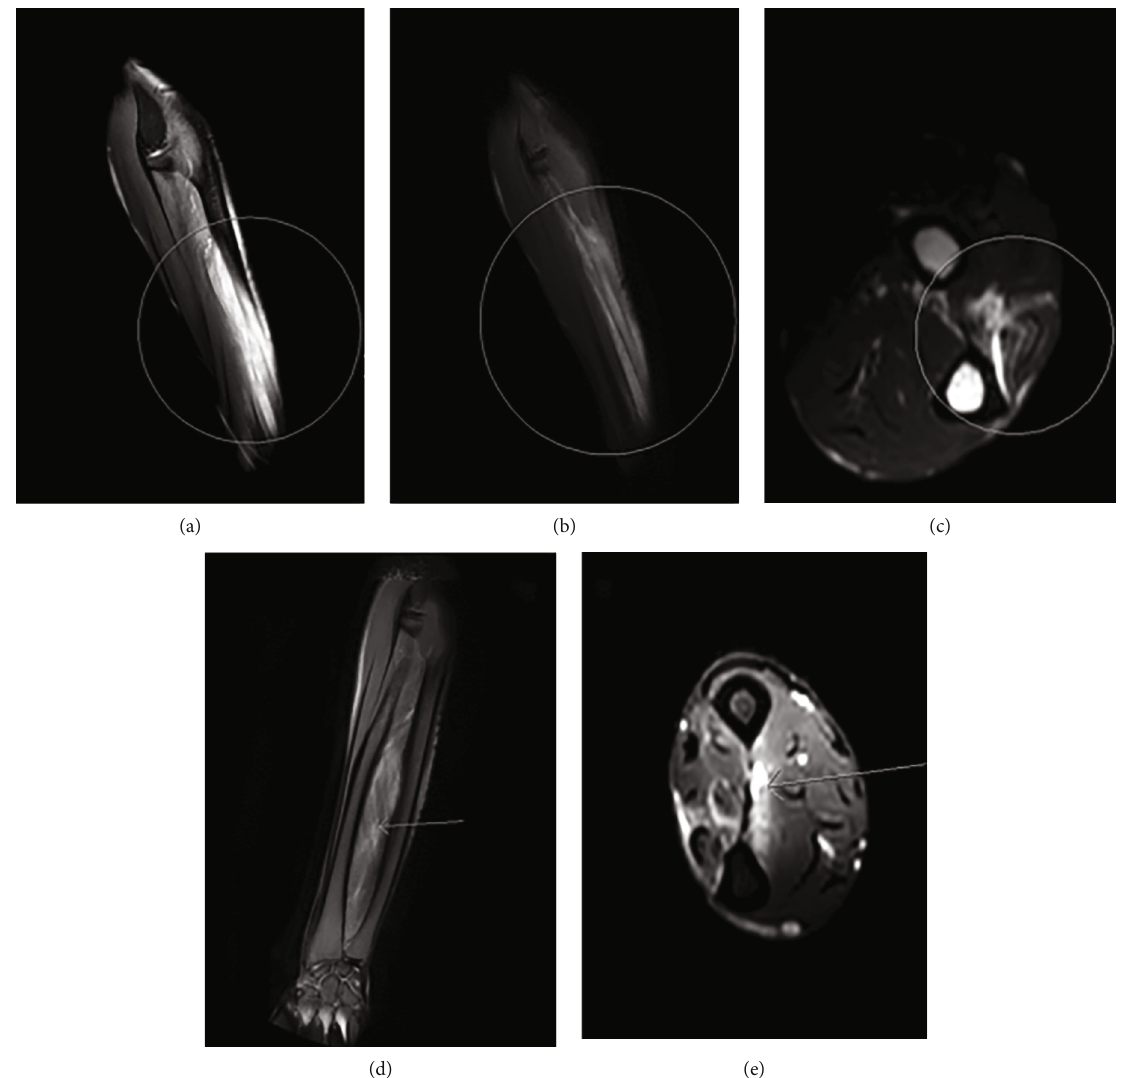
Figure 1: Magnetic resonance imaging of the arms. (a) – (c) Heterogenous T2-hyperintensitivity of the extensor carpi ulnaris muscle of the left arm, with surrounding edema of the fascia and subcutis.(d, e) Heterogenous T2-hyperintensitivity of the deep fl exor and extensor muscles, super fi cial extensor muscles, and extensor carpi radialis brevis muscle. Edema of the fascia was also